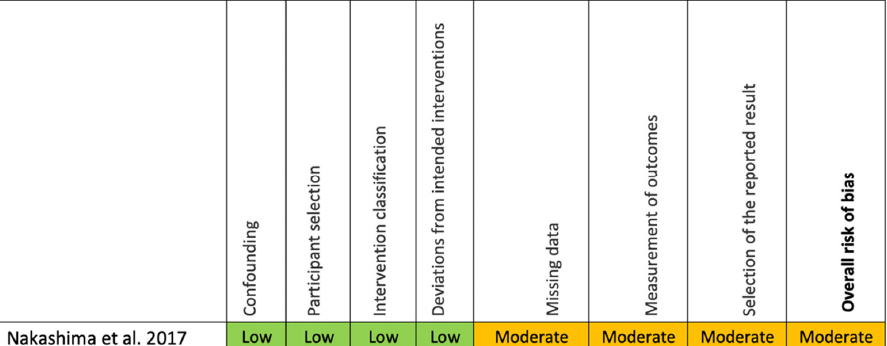
Figure 4. Risk of bias assessment for the clinical trial using the Risk of Bias in Non-Randomized Studies of Interventions (ROBINS-I)